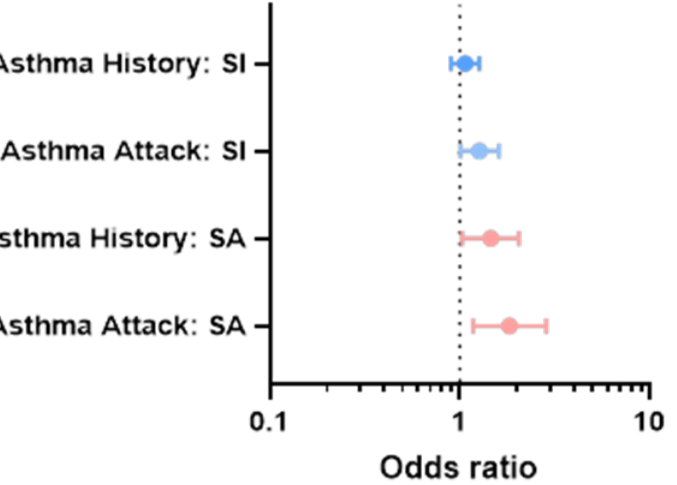
0.004 a Model 1 co-varies for demographics: age, sex, race (Black, White, Other) and Hispanic ethnicity. b